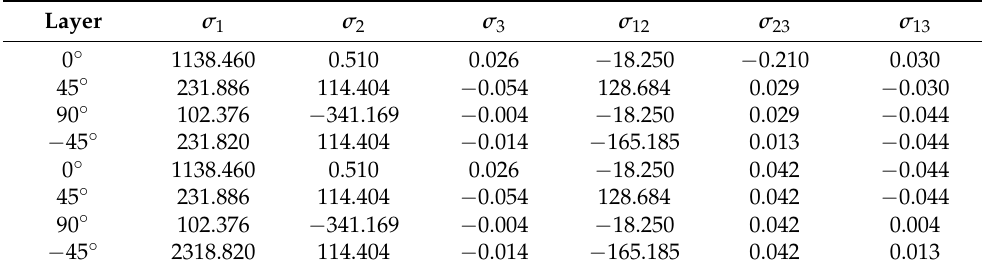
Table 10. Input stresses (MPa) are computed by the FE